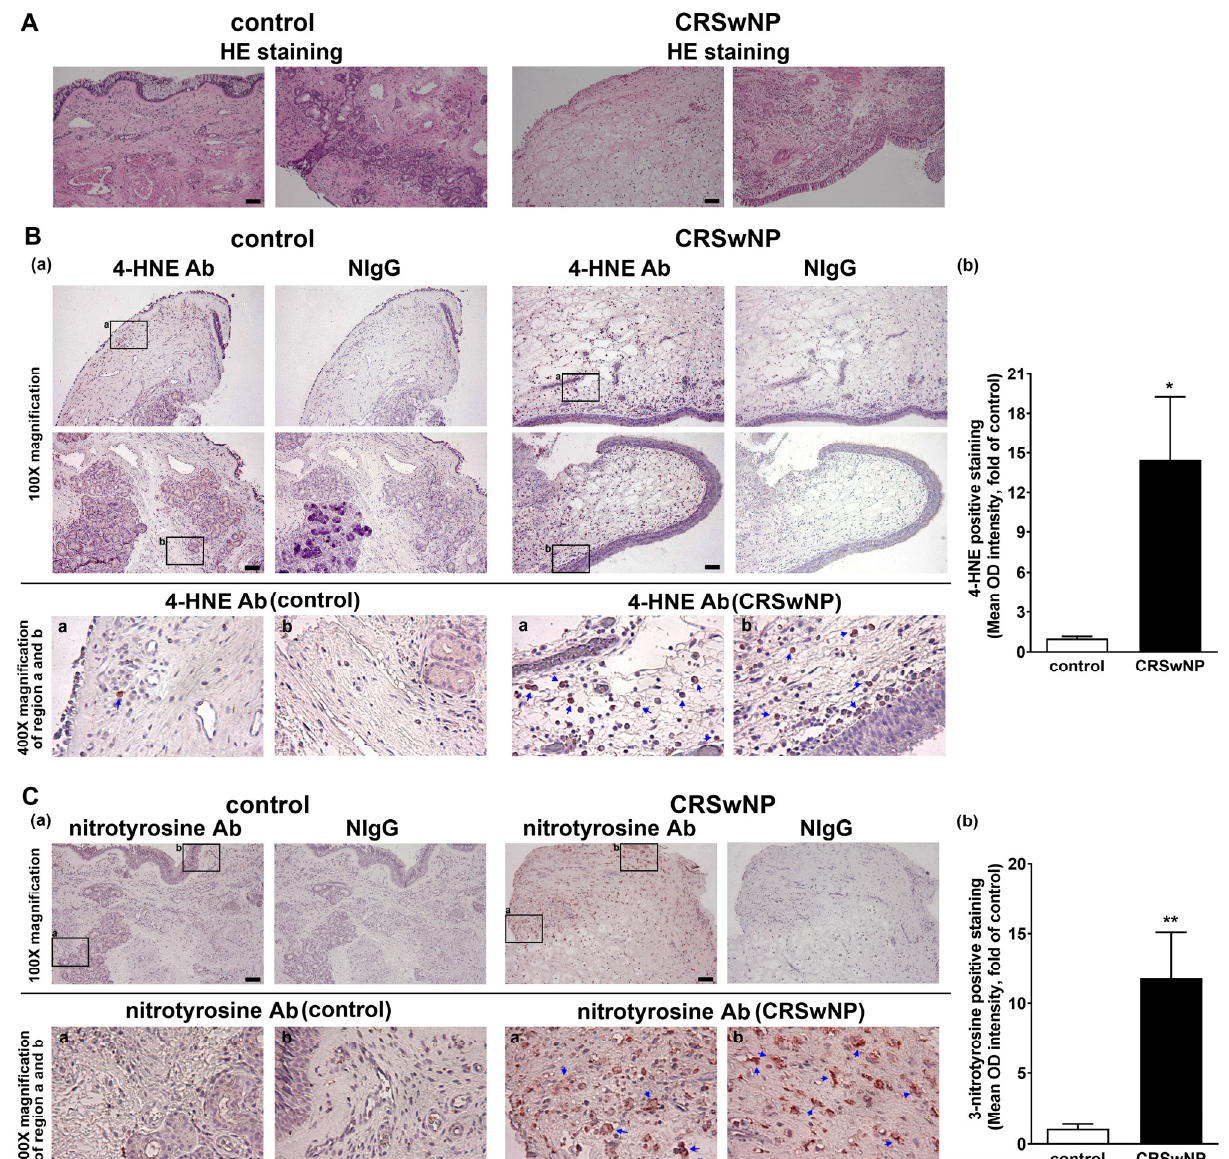
Figure 1. IHC analysis of 4-HNE and 3-nitrotyrosine expression levels in nasal tissues. The control nasal mucosae and NPs were stained by ( A ) hematoxylin and eosin (HE) staining and ( B ) anti-4-HNE Ab or ( C ) 3-nitrotyrosine Ab and its corresponding nonimmune IgG (NIgG). The selected regions (black rectangle frames ( a , b ) were magnified and images were captured under a microscope. The images shown below indicate positive staining, in which the deep red color spots/areas indicate the presence of 4-HNE or 3-nitrotyrosination (blue arrows) (panel ( a )). A quantitative analysis of similar data for 4-HNE ( n = 6) and 3-nitrotyrosine ( n = 3) staining is also shown (panel ( b )). Scale bar = 100 μ m. * p < 0.05 and ** p < 0.01 versus control.